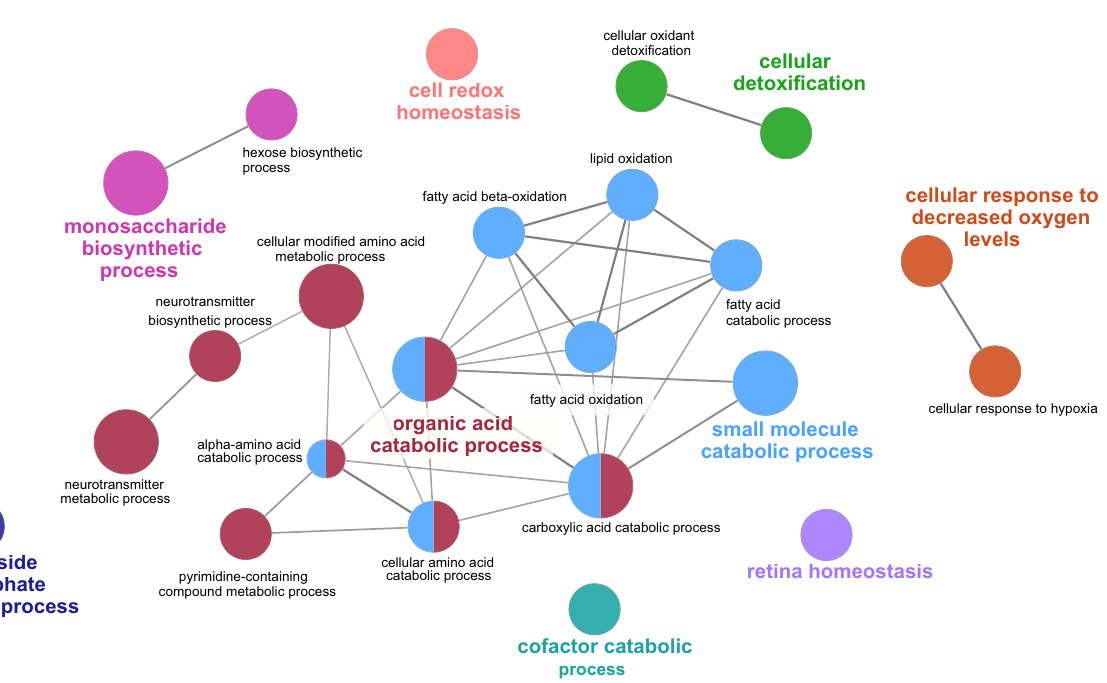
Figure 2. Functional classification of differentially ( P < 0.05) expressed proteins in the liver after feeding a NP or LP ration based on Gene ontology biological processes using ClueGO software (version 3.8.0; Cytoscape Software; https:// cytos cape. org).